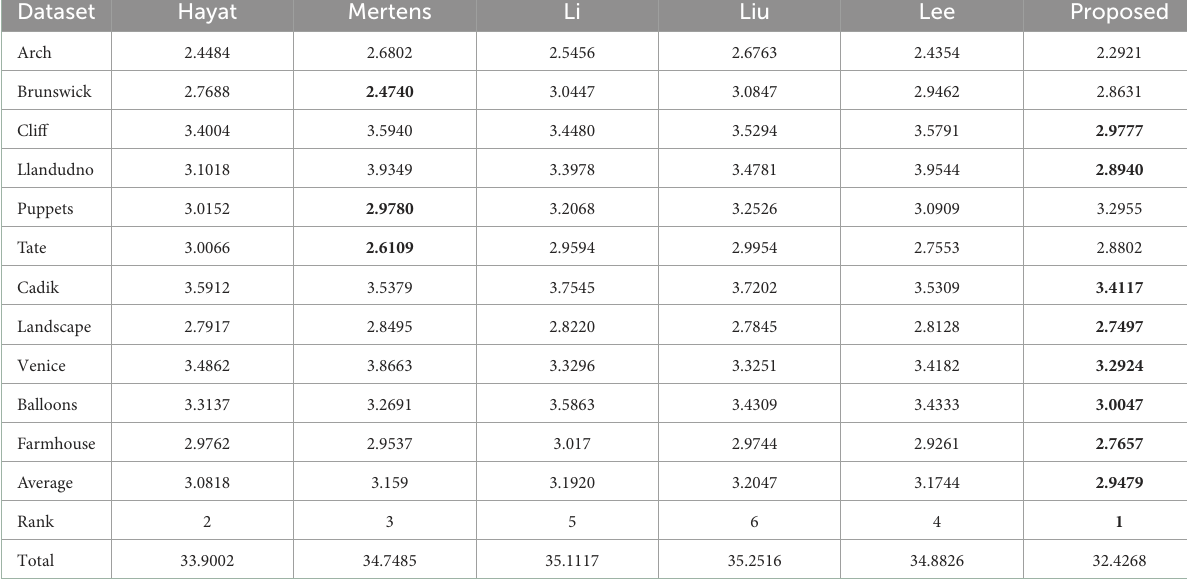
TABLE 2 NIQE comparison results of the MEF